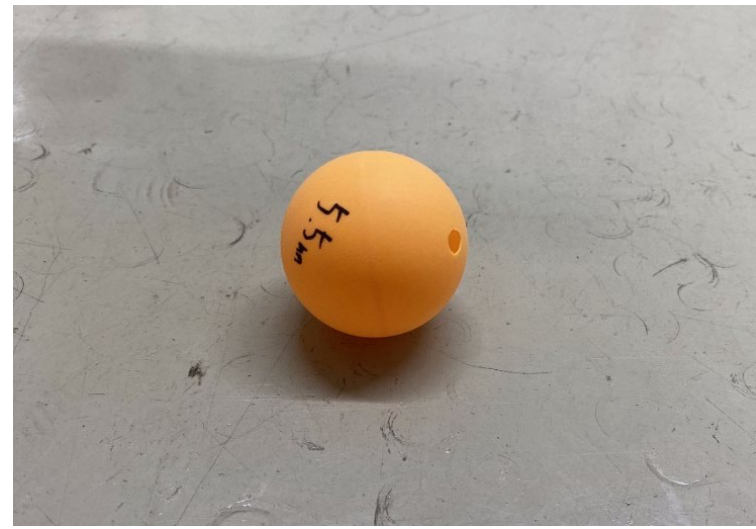
Figure 5. Appearance of a ball (The diameter of the ball is 44 mm. Its weight is 2.5 g.).